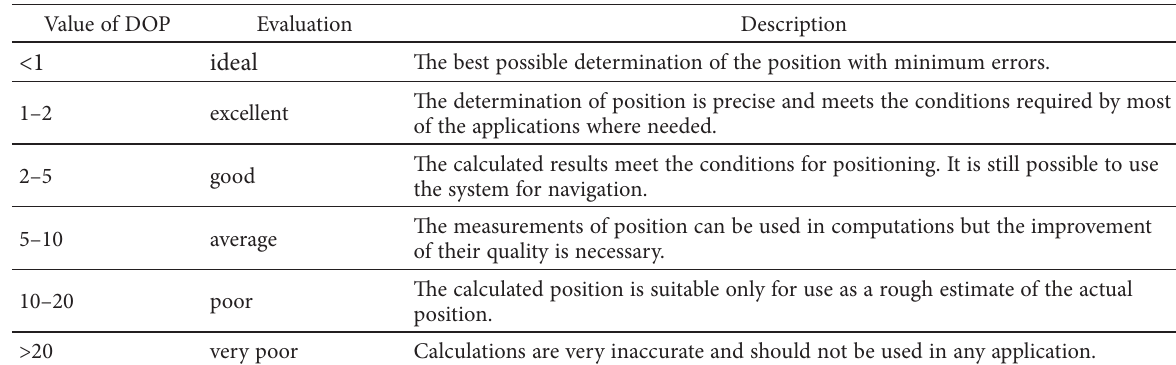
Table 1. Description of the values of the geometric dilution of precision and the influence on precise positioning (Langley 1999) Value of DOP Evaluation Description <1 ideal The best possible determination of the position with minimum errors. The determination of position is precise and meets the conditions required by most excellent of the applications where needed. good average poor very poor Calculations are very inaccurate and should not be used in any